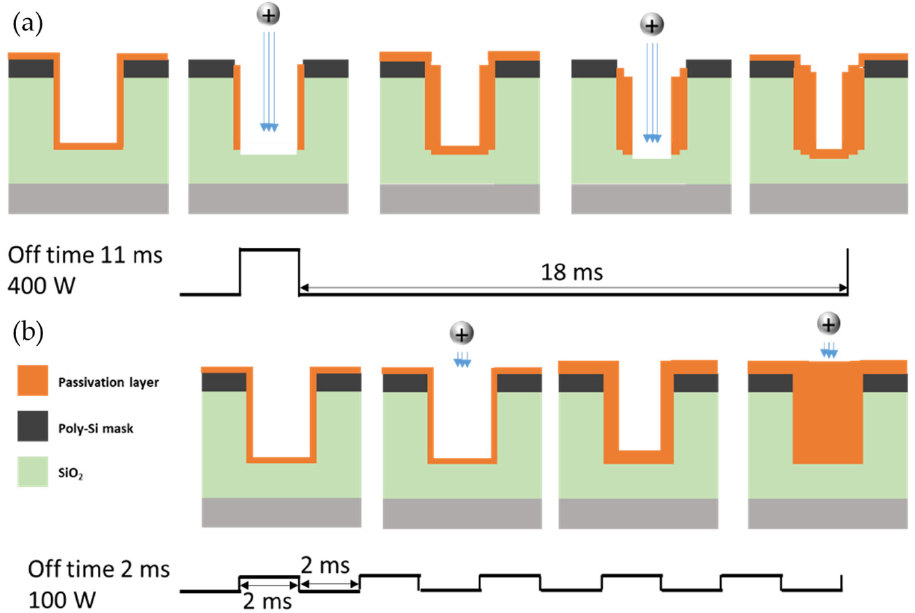
Figure 11. Etch profile mechanism in two different conditions: ( a ) RF power of 400 W and off-time of 11 ms giving a triangular etch profile, and ( b ) RF power of 100 W and off-time of 2 ms giving a deposition profile.